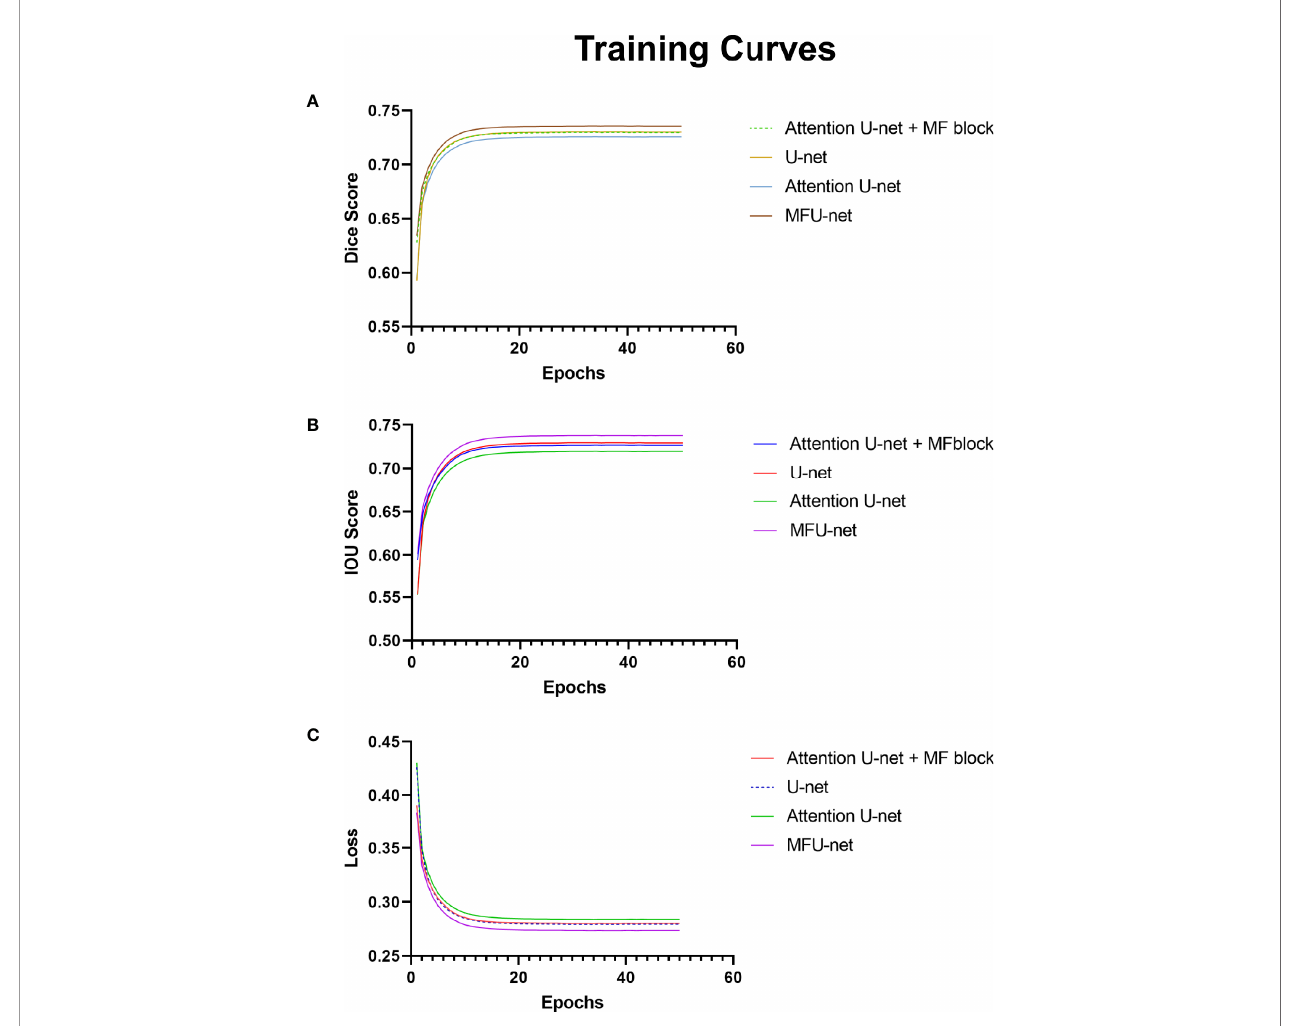
FIGURE 4 | Experiments on 3Dircard training set. (A) Training curves of dice score; (B) training curves of IOU score; (C) training curves of